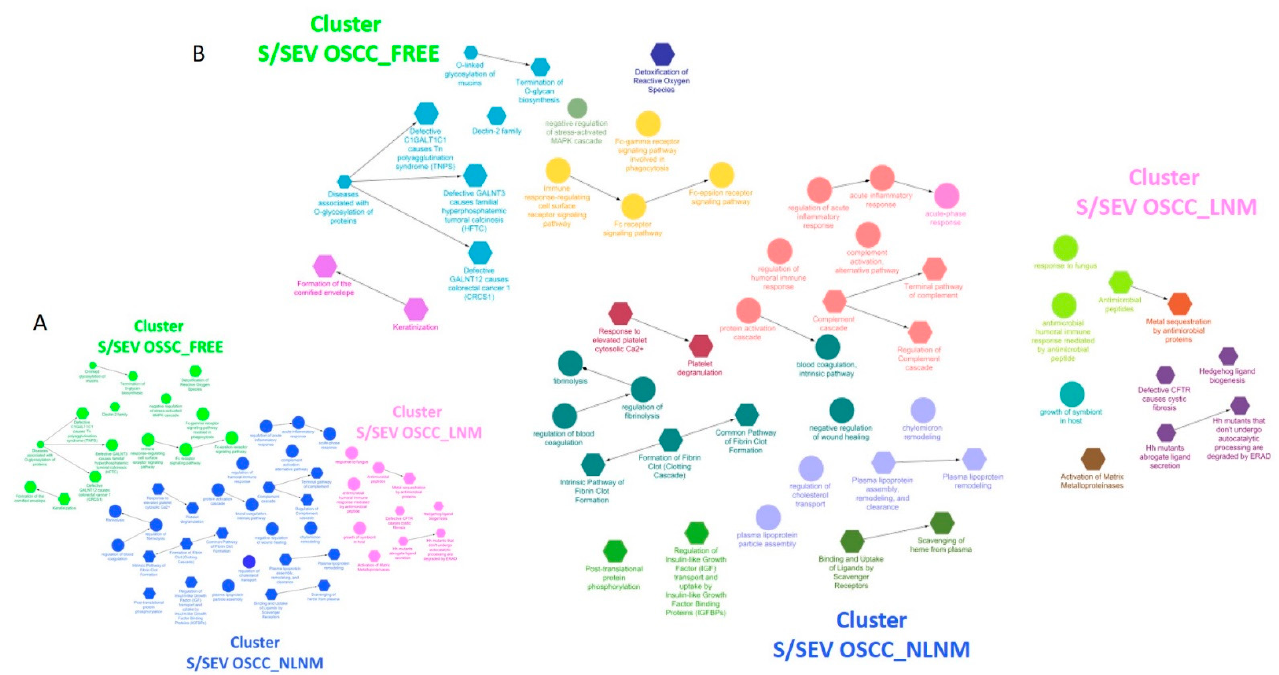
Figure 5. ( A ) ClueGo analysis of the proteins up-represented in each of the three S/SEV subtypes highlighting different clusters of enriched functional network terms (Adj p -value < 0.05); ( B ) within each identified cluster, the terms/nodes with the same color form a GO functional groups (see for details Figure 6). Within the clusters, each node represents a term of “biological process” (circle) or a Reactome pathway (hexagon), and the arrows represent direct relations between the nodes. Nodes are specifically related to a cluster when at least the 75% of the proteins of the node belong to that cluster.